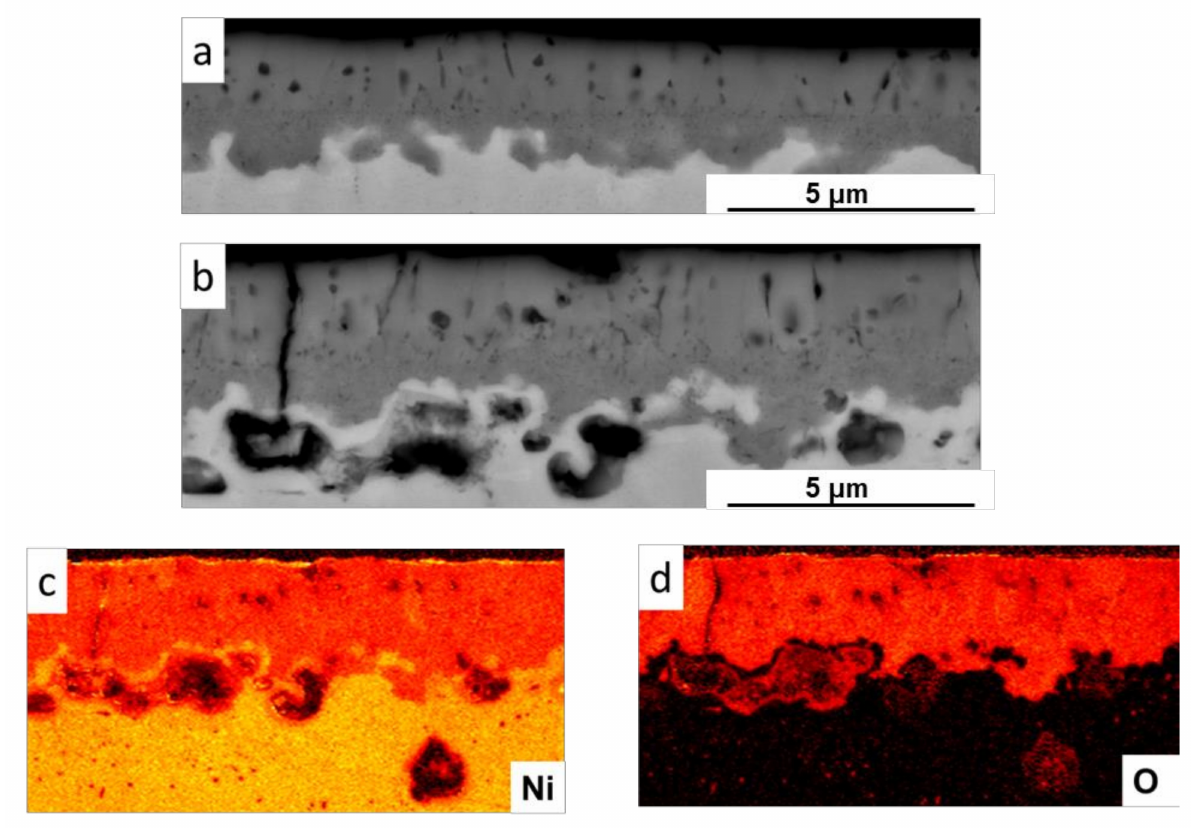
Figure 2. SEM morphologies of ( a ) Ar- and ( b ) H-permeated specimen; ( c ) Ni and ( d ) O distribution of H-permeated specimen obtained by